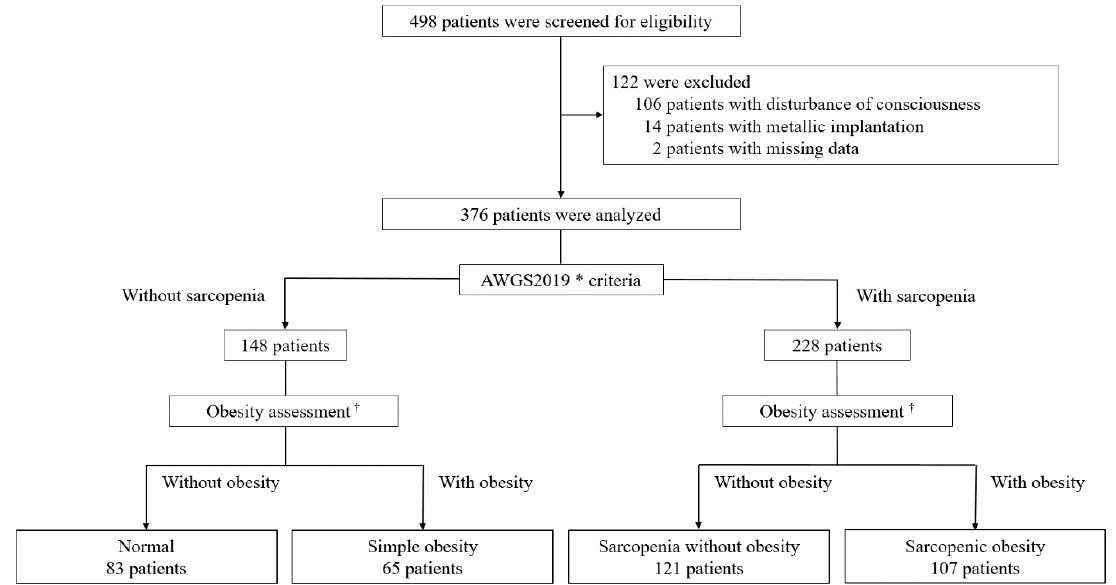
Figure 1. Flowchart of study participants. * AWGS, Asian Working Group for Sarcopenia 2019. † The cutoff values for body fat percentage to define obesity were ≥ 27% and ≥ 38% in men and women, respectively.